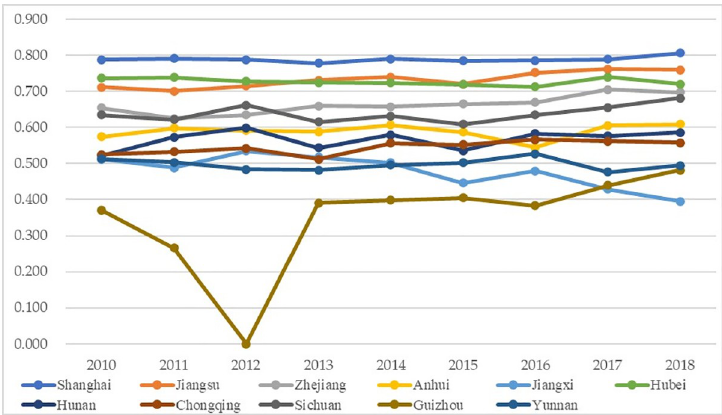
Fig 8. Coordinated growth performance between higher education and science